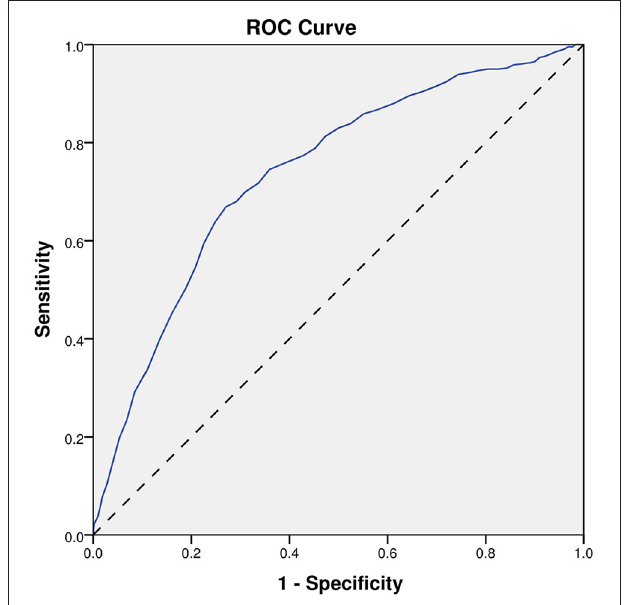
FIGURE 2 | ROC curve of age. ROC, receiver-operating